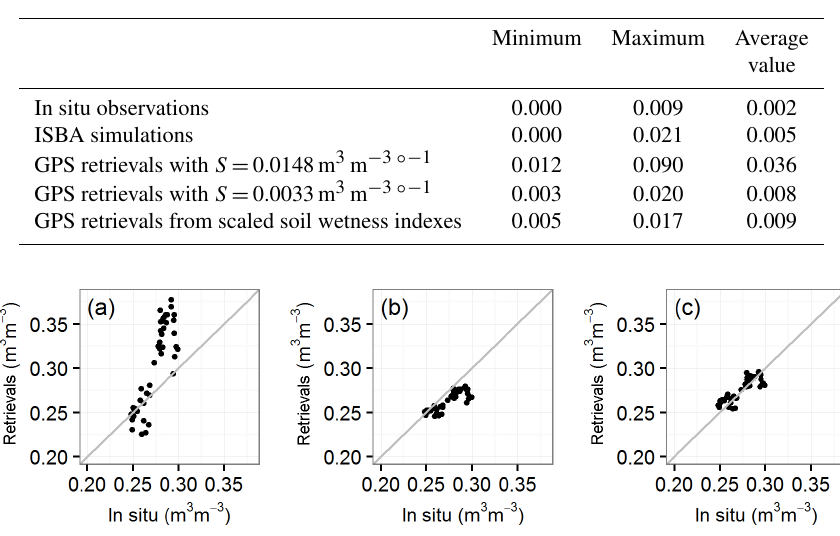
Table 2. Sub-daily variability (standard deviation, in m 3 m − 3 ) of VSM estimates.